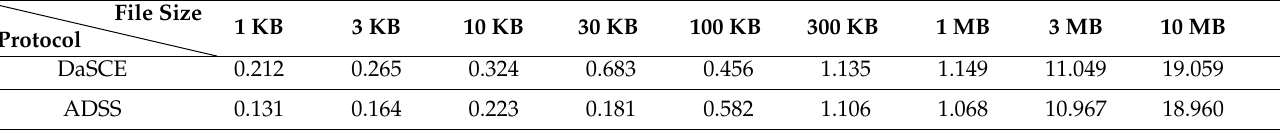
Table 3. Time cost of ADSS and DaSCE protocols in file download stage.